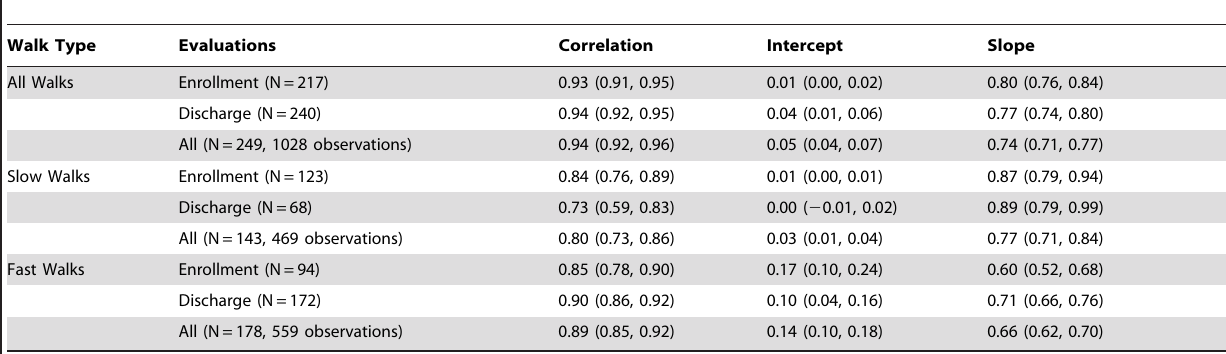
Table 2. Assessment of linear relationship between 6MWT and 10MWT via correlation and regression.